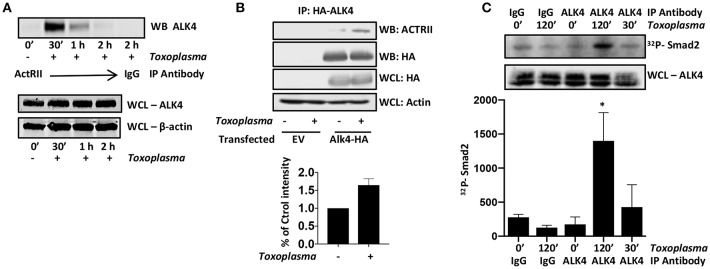
Toxoplasma Induces ALK4/ActRII Dimerization and Activation. (A) ActRII was immunoprecipitated from lysates prepared from mock- or parasite-infected cells and immune complexes were Western blotted to detect ALK4. ALK4 and β-actin (as a loading control) levels were assessed in whole cell lysates (WCL). (B) Host cells transfected with plasmid encoding HA-tagged ALK4 (or an empty vector) was mock- or parasite-infected for 30′. Lysates were prepared and incubated with anti-HA antibody and Protein A Sepharose. Immune complexes were collected and Western blotted using anti-ActRII antisera. Whole cell lysates (WCL) were also Western blotted to assess total protein levels. (C) Lysates from mock- or parasite-infected cells were incubated with the indicated antibody and Protein A Sepharose. Immune complexes were collected and then incubated with recombinant SMAD2 and 32Pγ-ATP. Reactions were separated by SDS-PAGE and then the gels were dried, exposed to a Phosphorimager screen, and analyzed by densitometry. Shown is a representative autoradiograph and the graph represents the average and standard deviation of three independent experiments. *<p< 0.05 (One Way ANOVA).